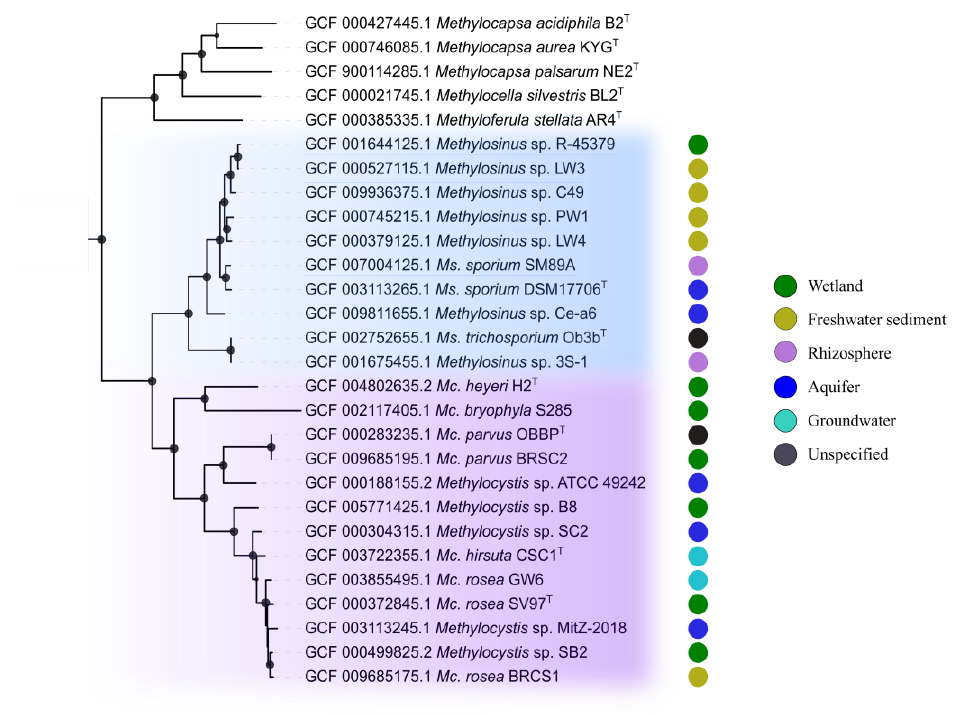
Figure 1. Phylogenomic tree showing the positions of representatives of the genera Methylocystis and Methylosinus in relation to other alphaproteobacterial methanotrophs based on the comparative sequence analysis of 120 ubiquitous single-copy proteins. The clades composed of Methylosinus and Methylocystis species are highlighted by blue and purple, respectively. The colored circles indicate isolation sources. The tree was constructed using the Genome Taxonomy Database toolkit [41], release 04-RS89. The significance levels of interior branch points obtained in maximum-likelihood analysis were determined by bootstrap analysis (100 data re-samplings). Bootstrap values of > 70% are shown by black circles. The root (not shown) is composed of 42 genomes of gammaproteobacterial methanotrophs. Scale bar indicates the number of substitutions per amino acid position.